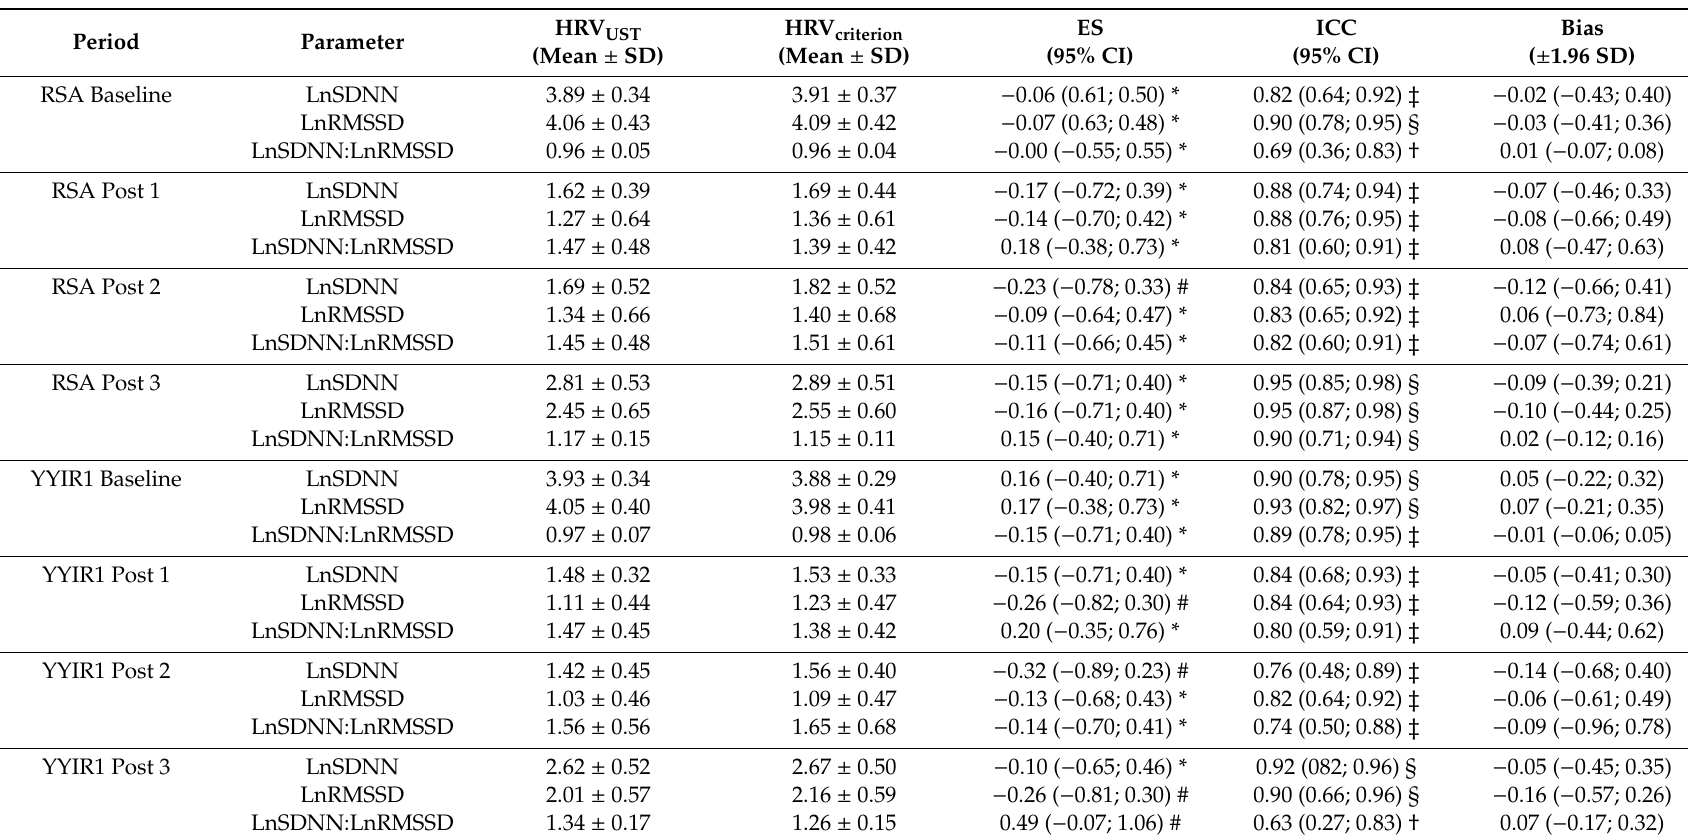
Table 2. Natural logarithm of standard deviation of normal-to-normal intervals (LnSDNN), root mean square di ff erences between adjacent normal R-R intervals (LnRMSSD), and LnSDNN:LnRMSSD ratio during 0–1 min and 0–5 min of time segments of the baseline, post exercise 0–5 min, 5–10 min, and 25–30 min in the repeated sprint ability test and YoY o intermittent recovery test level 1